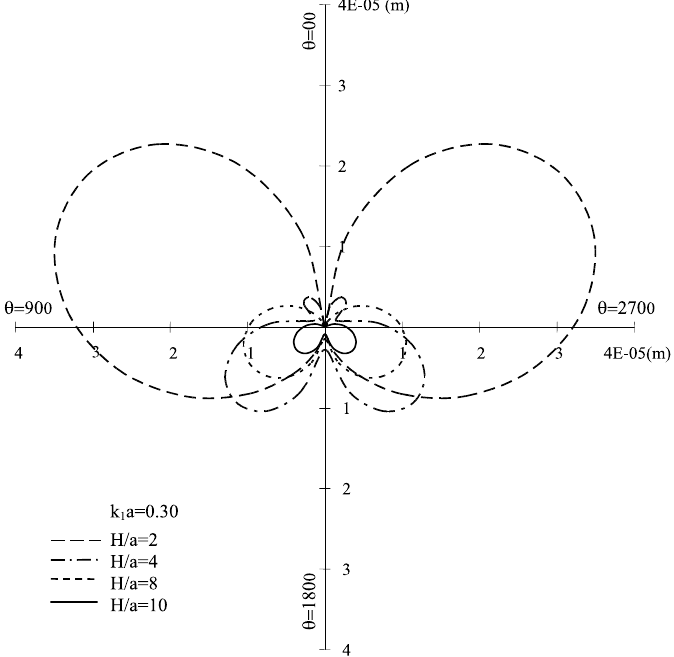
Fig. 7. Variation of the circumferential displacement ( u θ ) with θ at r = a for various values of depth H/a